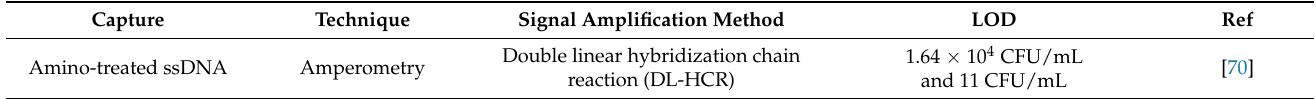
Table 6. Summarized data of DNA- based signal amplification method for Listeria